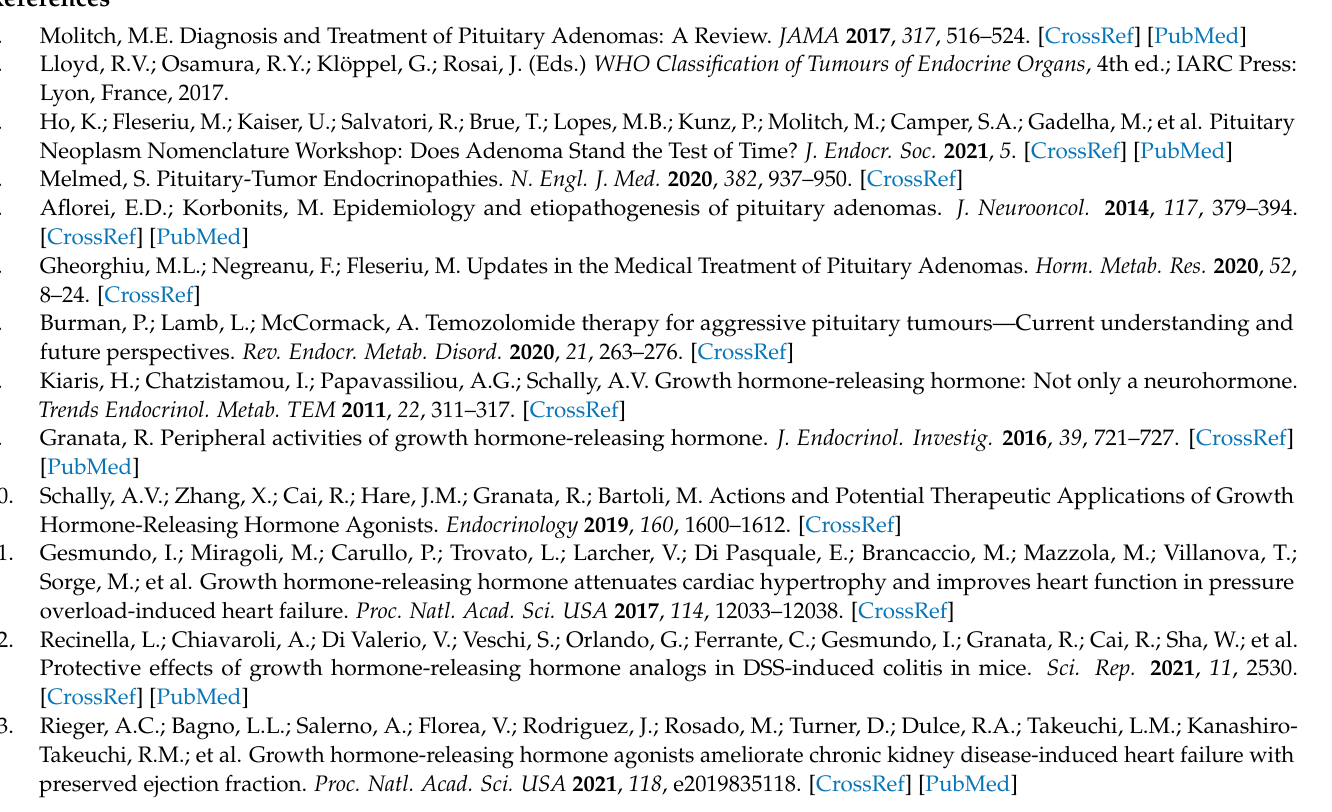
Figure 1B, Figure S5: Uncropped Figure 2D, Figure S6: Uncropped Figure 2E, Figure S7: Uncropped Figure 2I, Figure S8: Uncropped Figure 2J, Figure S9: Uncropped Figure 3C, Figure S10: Uncropped Figure 3D, Figure S11: Uncropped Figure 3E, Figure S12: Uncropped Figure 3H, Figure S13: Un- cropped Figure 3I, Figure S14: Uncropped Figure 3J, Figure S15: Uncropped Figure 5A, Figure S16: Uncropped Figure